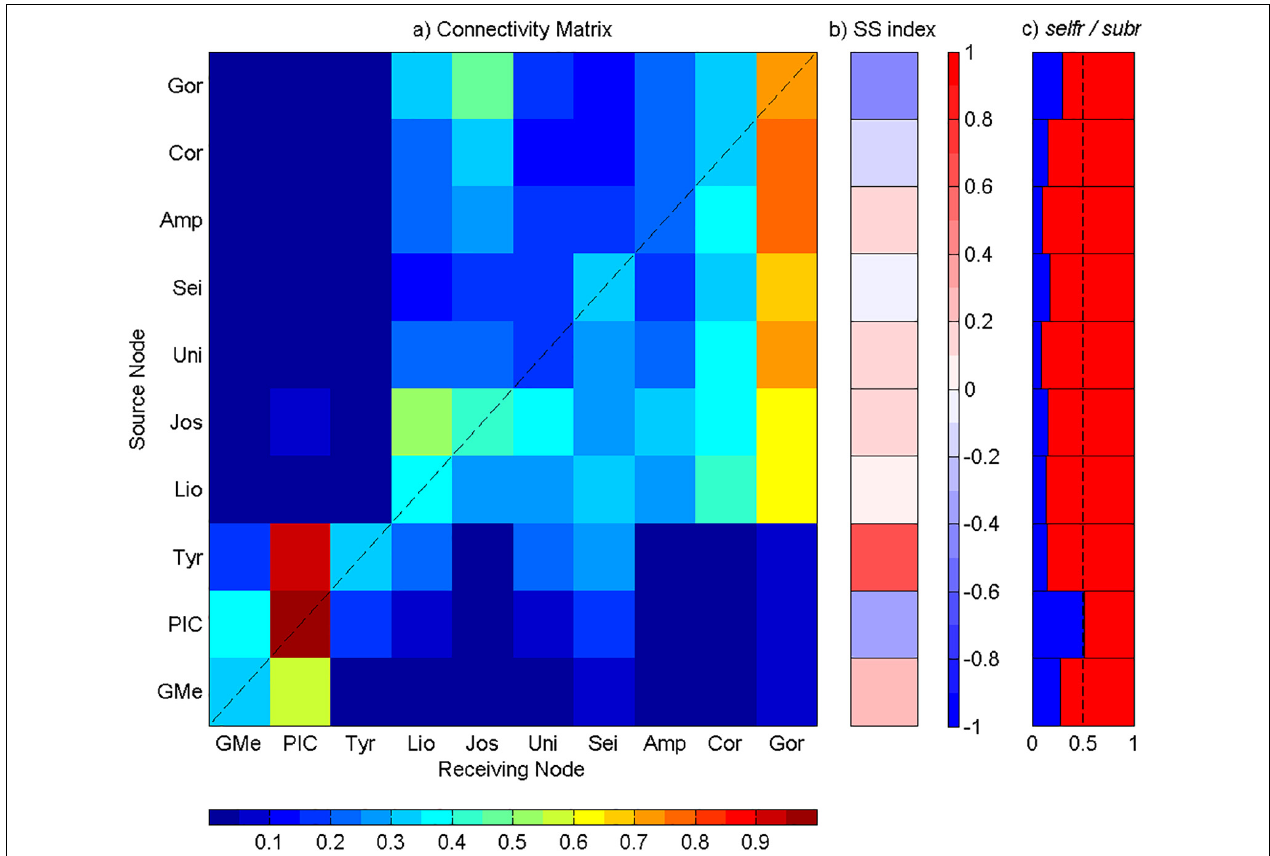
FIGURE 6 | Analysis of the connectivity among Great Meteor and Madeira-Tore complexes at the depth range of 20 to 200 m. (a) Connectivity matrix between the seamounts: GMe – Great Meteor; PIC – Plateau, Irving, and Cruiser; Tyr – Tyro; Lio – Lion; Jos – Josephine; Uni – Unicorn; Sei – Seine; Amp – Ampere; Cor – Coral; and Gor – Gorringe. The y -axis represents seamounts acting as sources and the x -axis represents seamounts acting as sinks. The connectivity degree increases from blue to red. (b) Source–sink indices for each seamount. (c) Self-recruitment ( selfr , blue color) and subsidy-recruitment ( subr , red color) fractions for each seamount. The dashed line corresponds to the reference value of